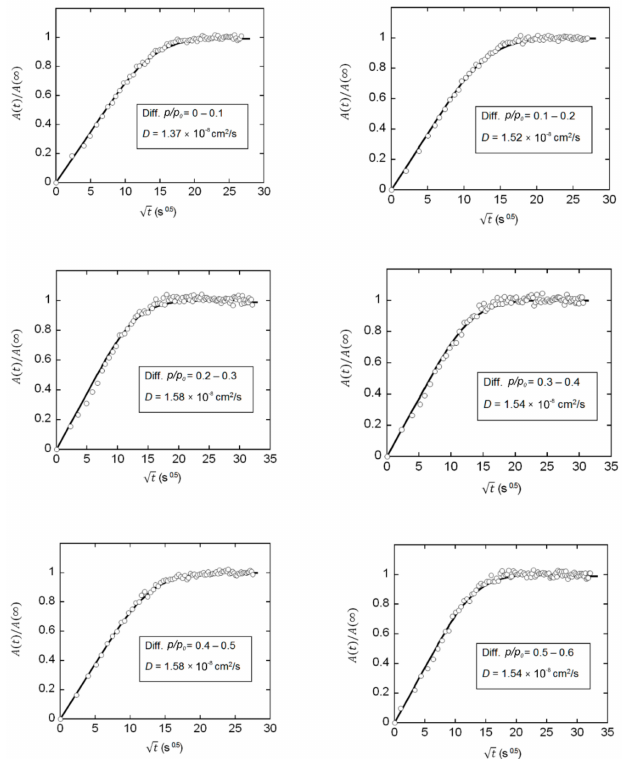
√ t) for the “differential sorption tests” performed in the p / p 0